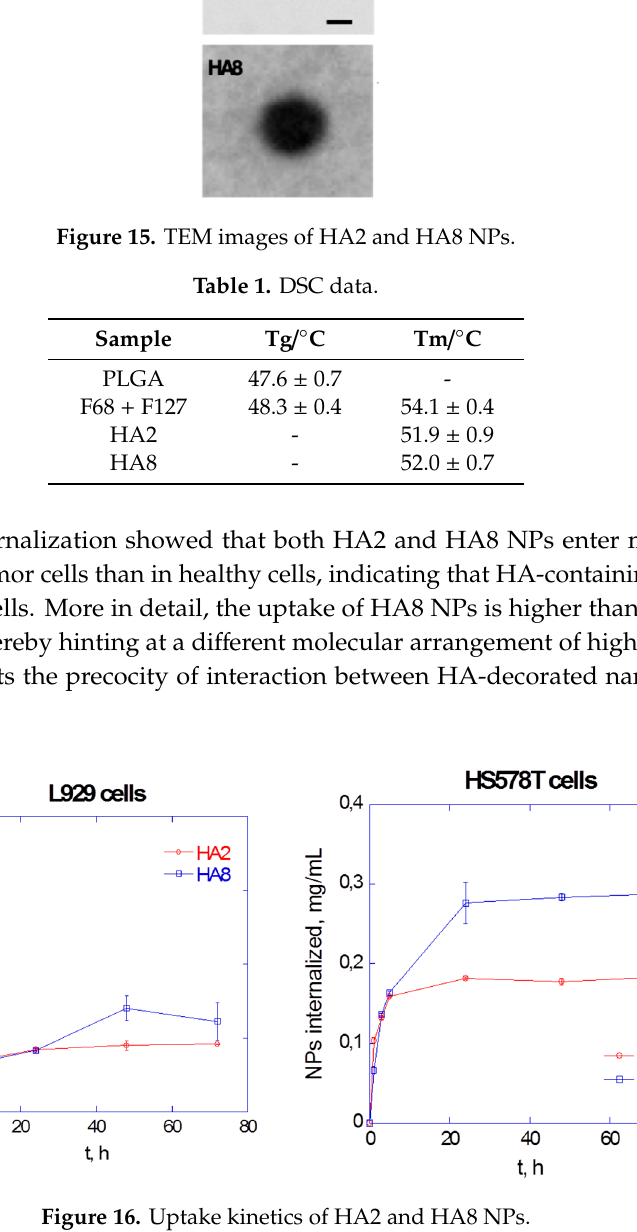
Figure 16. Uptake kinetics of HA2 and HA8 NPs.